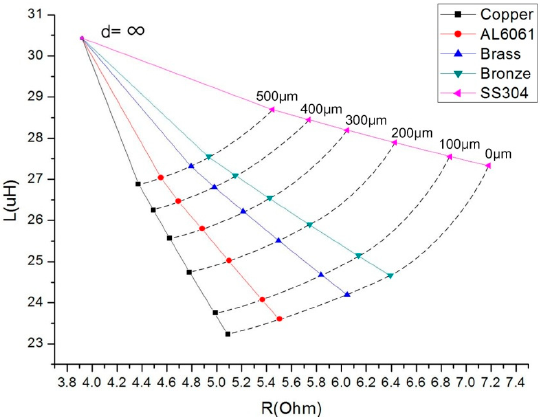
Figure 5. Coil impedance measurement system with gap controlled.